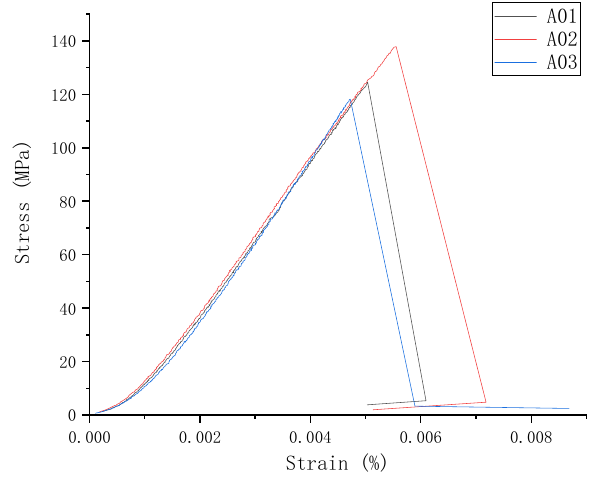
Figure 12. Uniaxial compressive stress–strain curves.